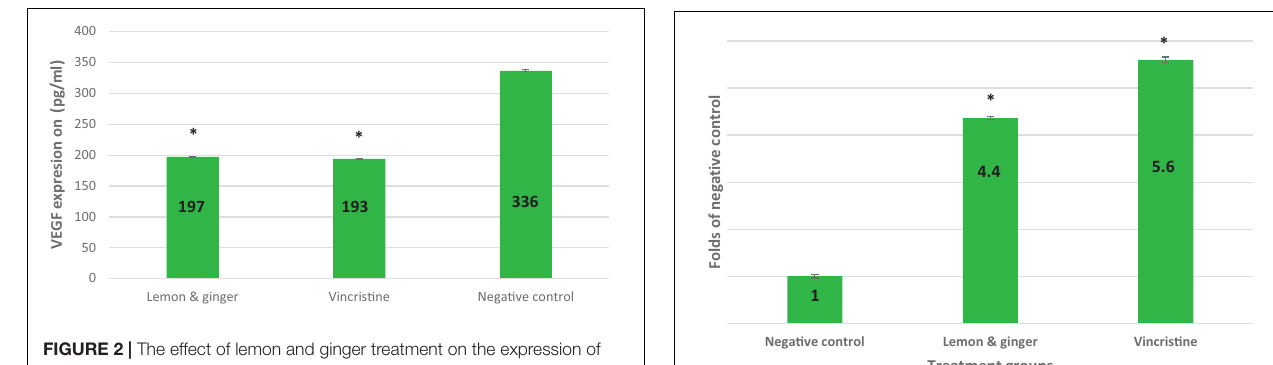
Frontiers in Nutrition |